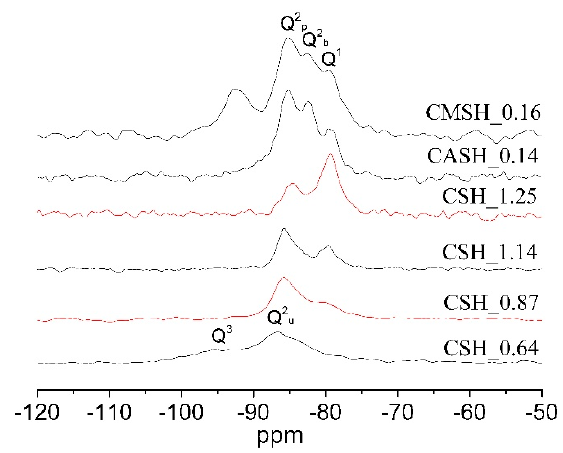
Figure 2. Nuclear magnetic resonance (NMR) spectra of C-(M)-(A)-S-H before carbonation. Table 2. Peak shifts, relative fraction of Q n , and mean chain length of C-(M)-(A)-S-H